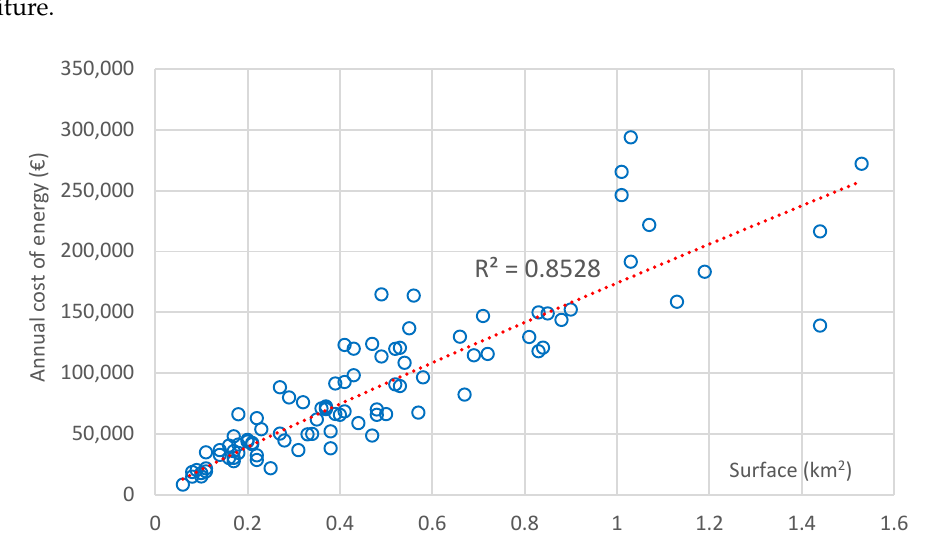
Figure 6. Cost of annual energy according to the surface of a municipality.